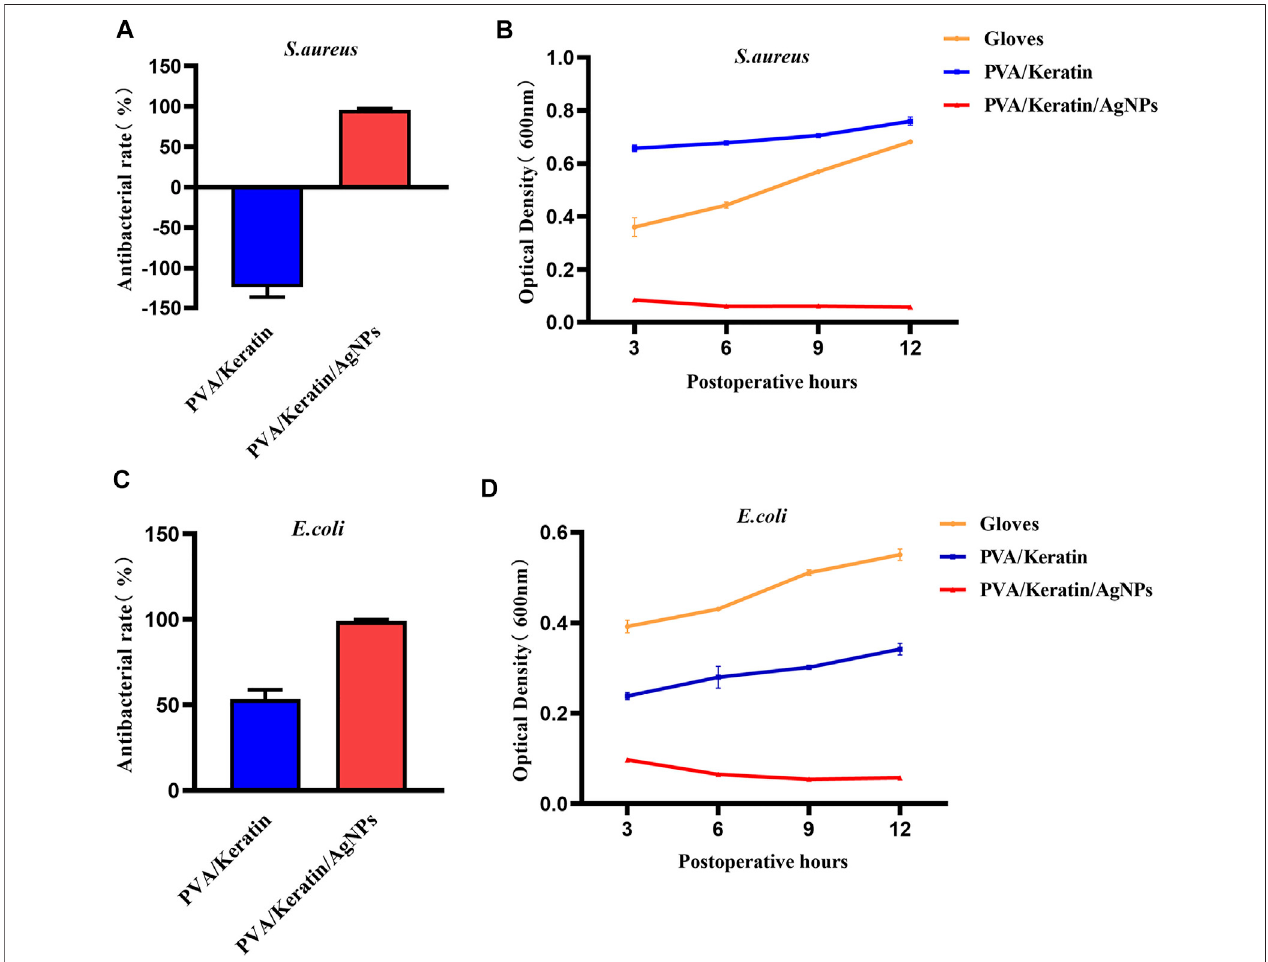
FIGURE9| Antibacterialrateandbacterialkineticsof S.aureus and E.Coliinvivo . (A,C) Antibacterialrateofdifferentmaterialsagainst S.aureus and E.Coli . (B,D) Bacterial kinetics of S. aureus and E.Coli on different materials.